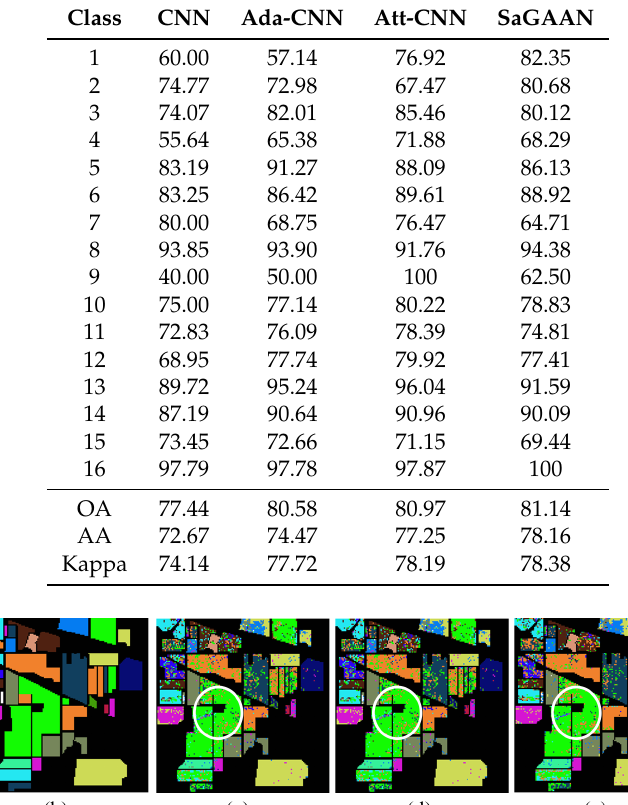
Table 3. Classification accuracies on Indian Pines dataset.